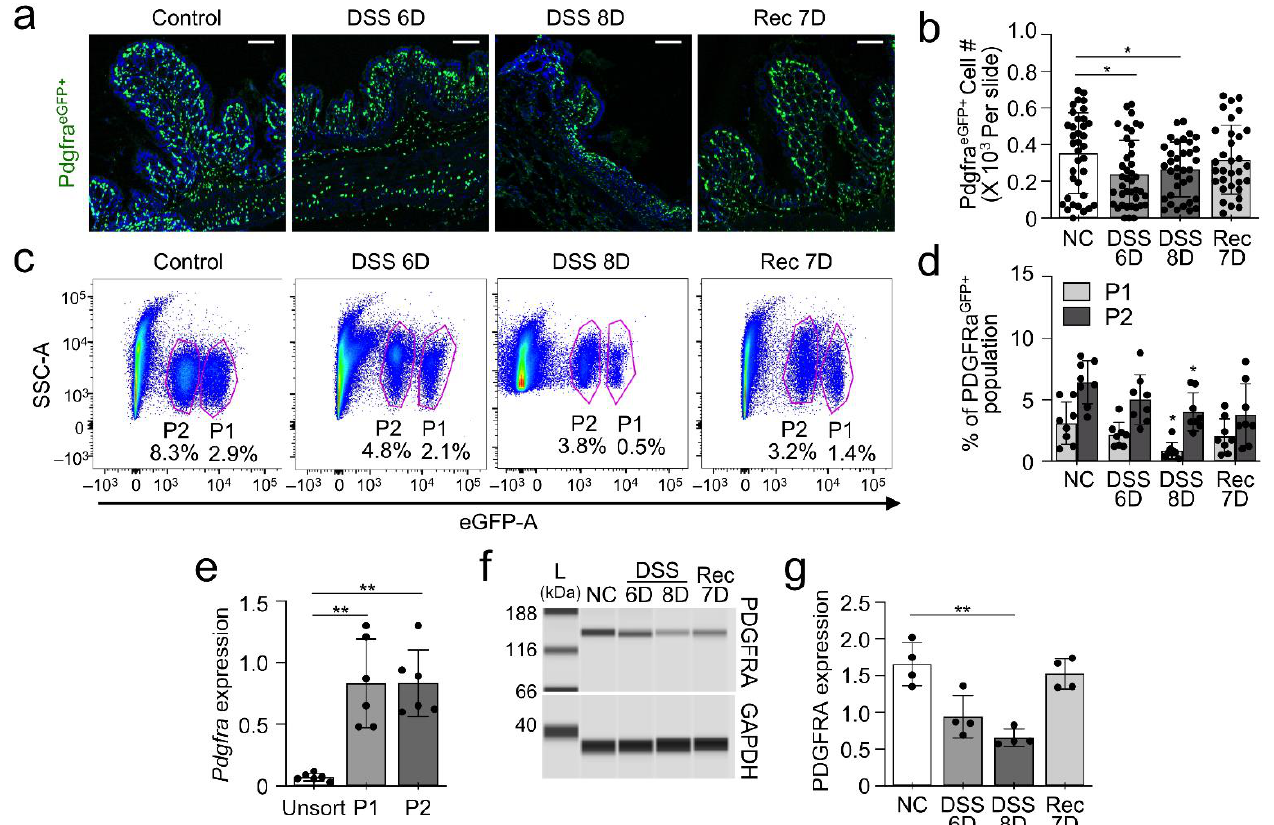
Figure 2. Loss of mucosal PDGFR α + cells in DSS-induced colitis mouse model. PDGFR α + cells in colonic mucosa identified by eGFP. ( a ) Reduction of PDGFR α + cells in DSS-treated mice after 6 days (DSS 6D)- and 8 days (DSS 8D) compared to non-treated control (NC) mice and recovery mice for 7 days post DSS treatment (Rec 7D). DSS-induced proximal and distal colonic mucosa and restoration of the cells in recovery colon. ( b ) Quantification of the number of PDGFR α + cells in ( a ) ( n = 20). * p < 0.05, versus NC groups. ( c ) Changes of PDGFR α + cell populations P1 and P2 in DSS-treated mice, compared with control and recovered mice. ( d ) Quantification of PDGFR α + cell populations P1 and P2 in (c) ( n = 10). * p < 0.05, versus NC groups ( e ) Pdgfra mRNA expression in PDGFR α + cell populations P1 and P2 ( n = 5). ** p < 0.01, versus unsorted. ( f ) Decrease of PDGFRA protein expression in colonic mucosa tissue from DSS-induced colitis mouse model. ( g ) Quantification of PDGFRA in ( f ) normalized by GAPDH ( n = 4). ** p < 0.01, versus NC